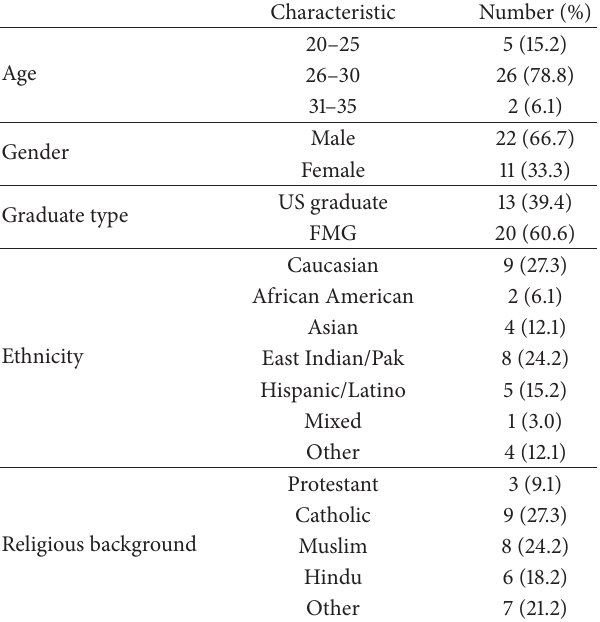
Table 1: Demographics ( 𝑛 = 33